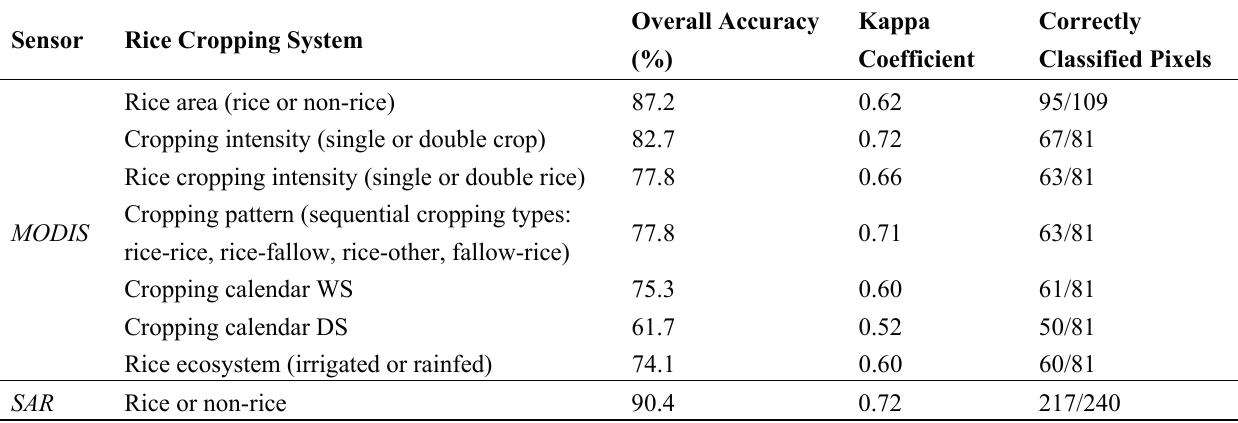
Table 5. Accuracy assessment of the cropping system information derived from MODIS for the whole Nueva Ecija and Pangasinan